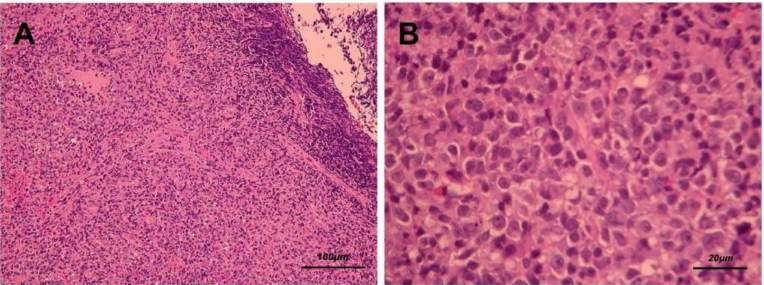
Figure 3. Hematoxylin and eosin staining ( A. 100 × and B. 400 × ) presents diffuse polymorphous